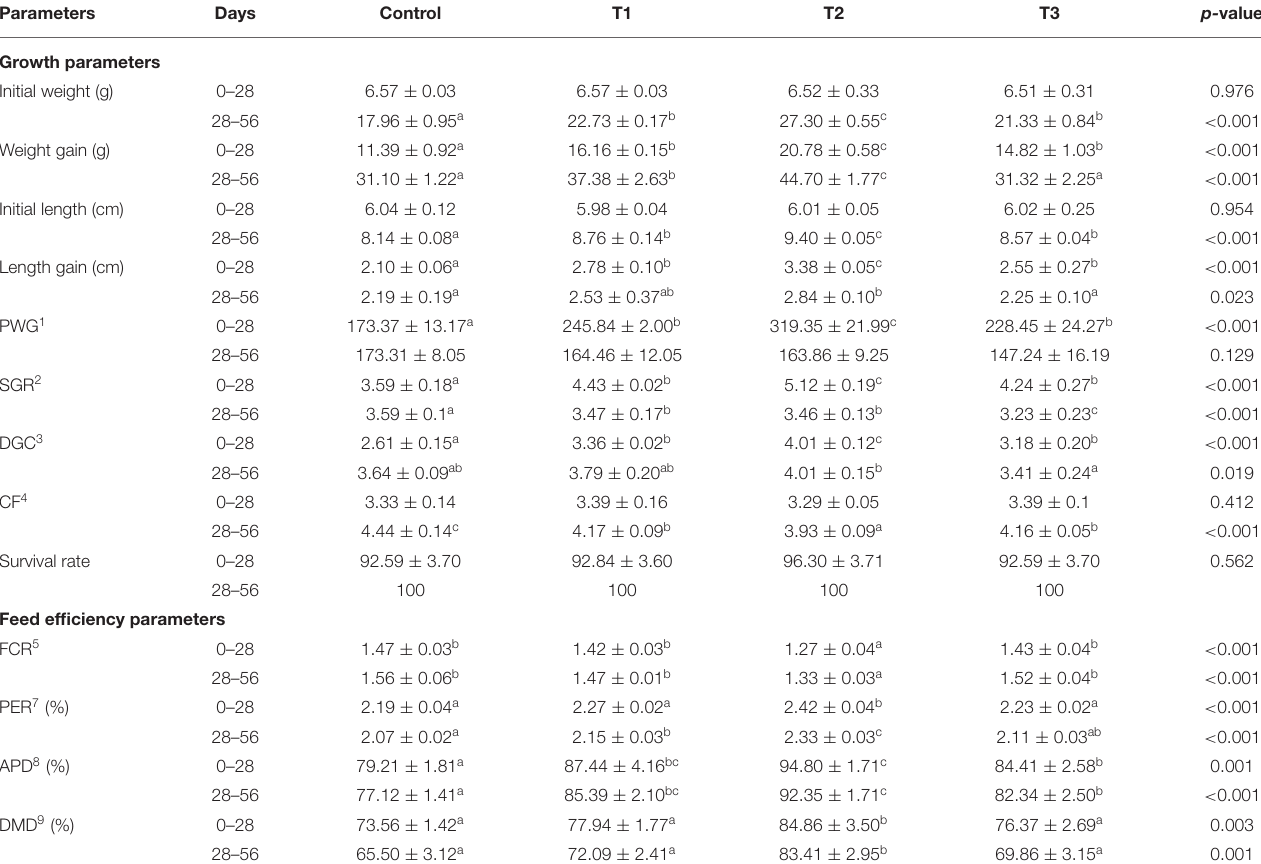
TABLE 2 | The effects of silica nanoparticle (NP) on growth performance and feed efficiency of experimental tilapia, Oreochromis niloticus, after 28 and 56 days of feeding trial.